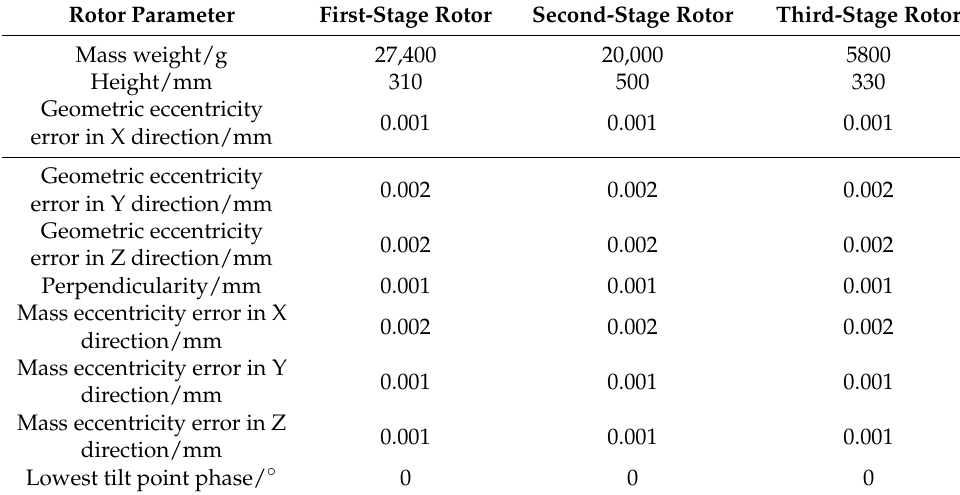
Figure 3. Vibration amplitude control diagram of drive end under working speed of rotary parts rotor system: ( a ) Three ‐ dimensional diagram of vibration amplitude changing with assembly phase; ( b ) Projection diagram of vibration amplitude changing with assembly phase.